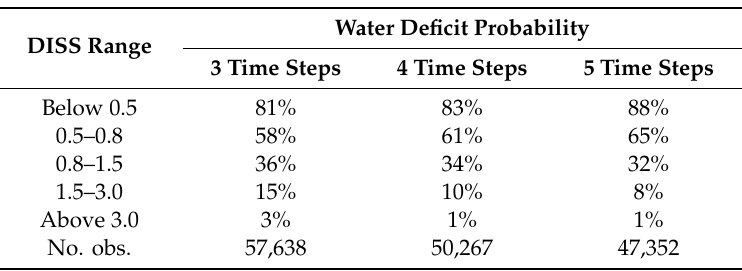
Table 3. Probability of compliance of the DISS index with the water deficit characterized by HTC. Water Deficit Probability DISS Range 3 Time Steps 4 Time Steps 5 Time